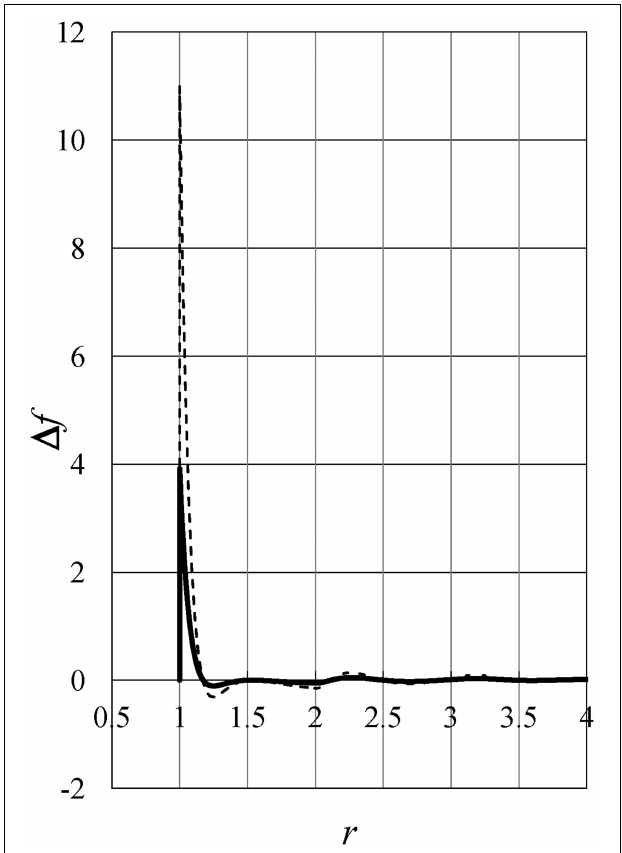
FIGURE 8 | The difference (cid:6) f ( r ,ρ, T ) as a function of distance r . Full and dashed lines show (cid:5) f ( r ,ρ 0 , + 4 ◦ C) and (cid:5) f ( r ,ρ 0 , − 20 ◦ C), respectively, where ρ 0 =